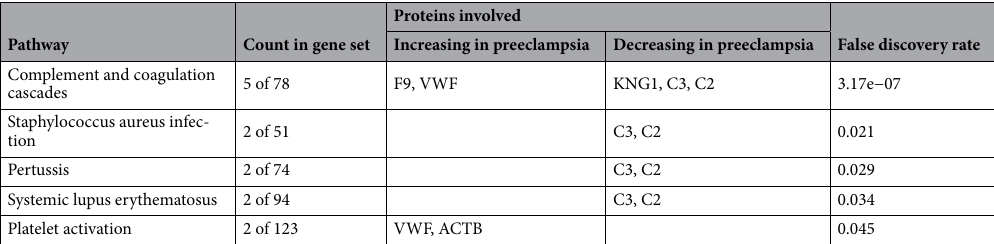
Table 3. Kyoto encyclopedia of genes and genome (KEGG) enrichment analysis of different proteins in preeclampsia vs controls. F9 coagulation factor IX, C3 complement C3, VW F Von Willbrand factor, KNG1 kininogen-1, C2 complement C2, ACTB Actin, cytoplasmic 1.